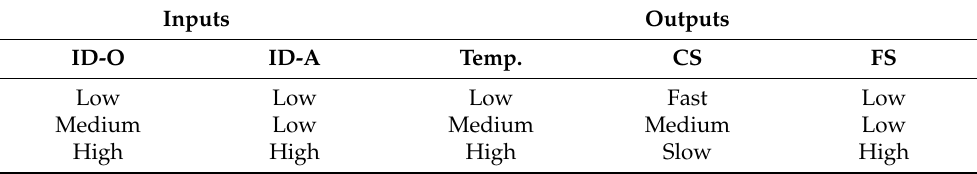
Table 3. Rules for indeterminacy membership of neutrosophic logic represented as (ID-O, ID-A).